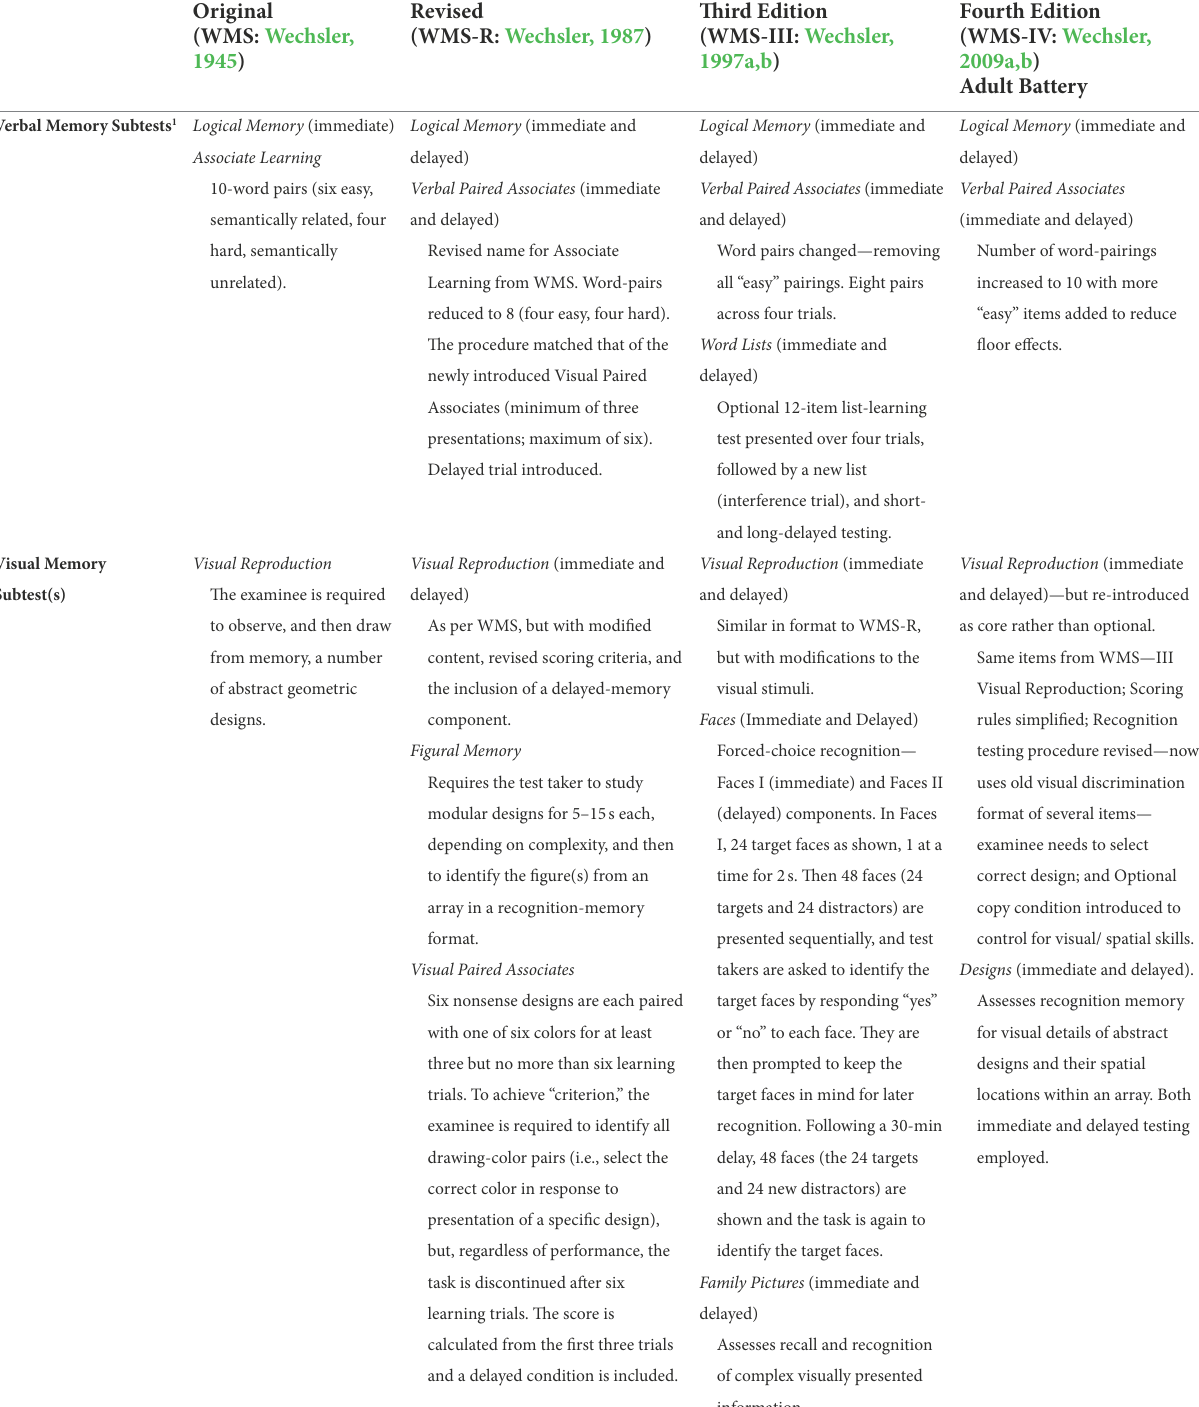
TABLE 1 Wechsler memory scales: history of visual memory assessment and assessment